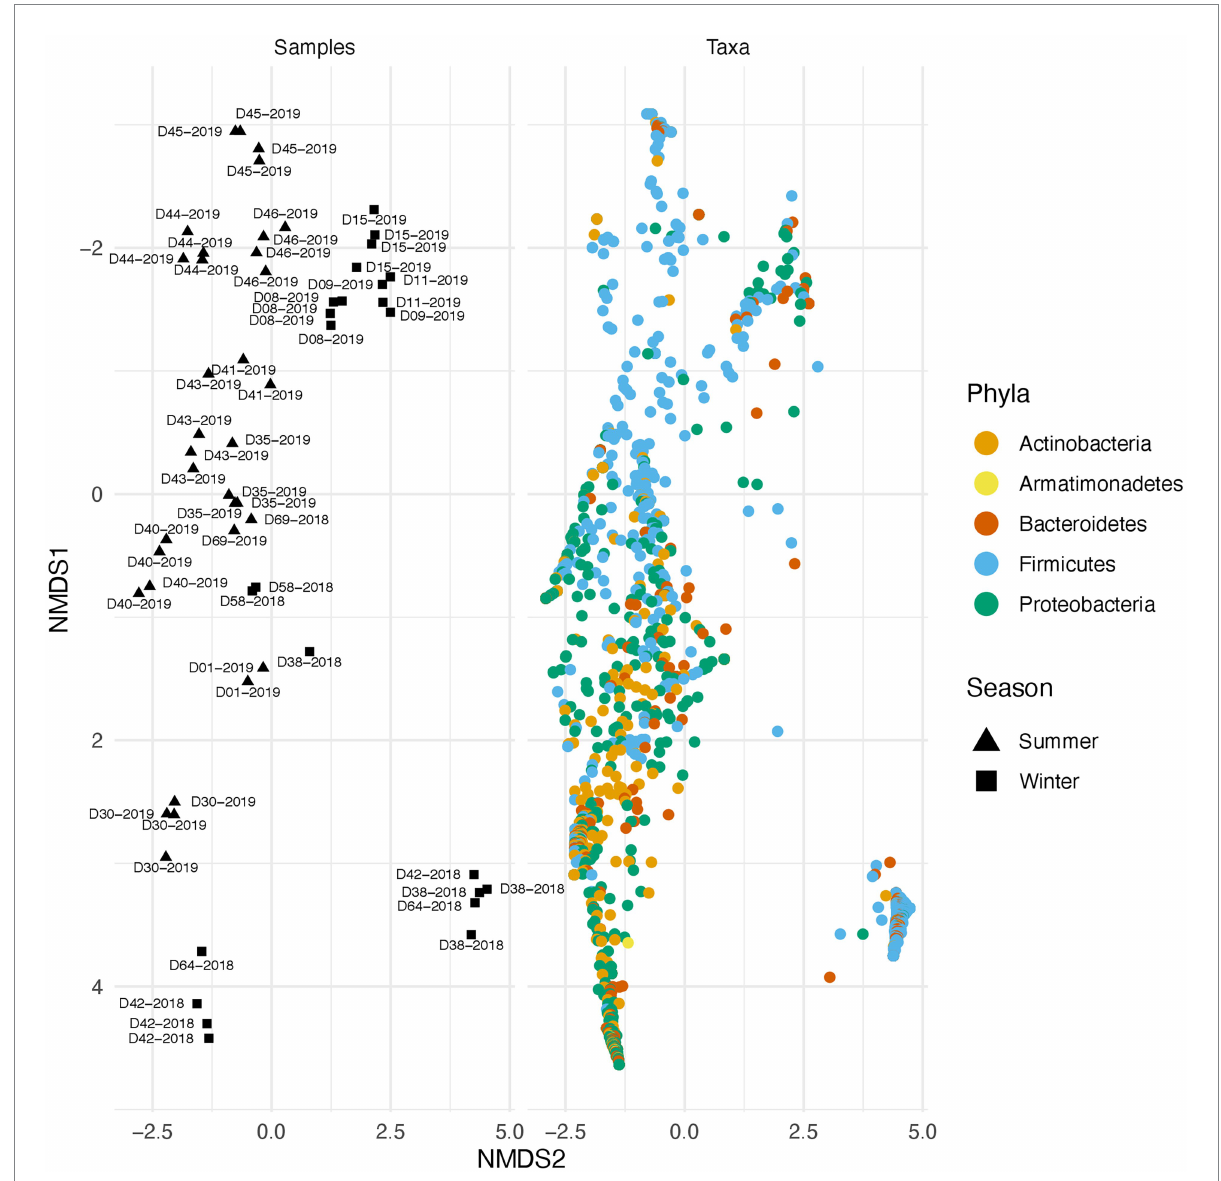
FIGURE 4 Taxonomic shift across different samples in summer and winter. Variation across samples is primarily driven by a shift in specific phyla. The plot on the right illustrates beta diversity across individual swabs. Plot on the left is identical to the one on the right but instead of samples, ASVs colored by phylum are